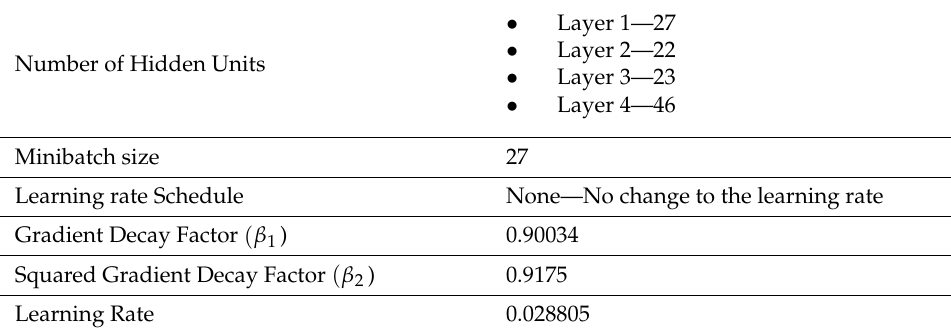
Table 4. List of Optimal hyperparameters found through BOpt.